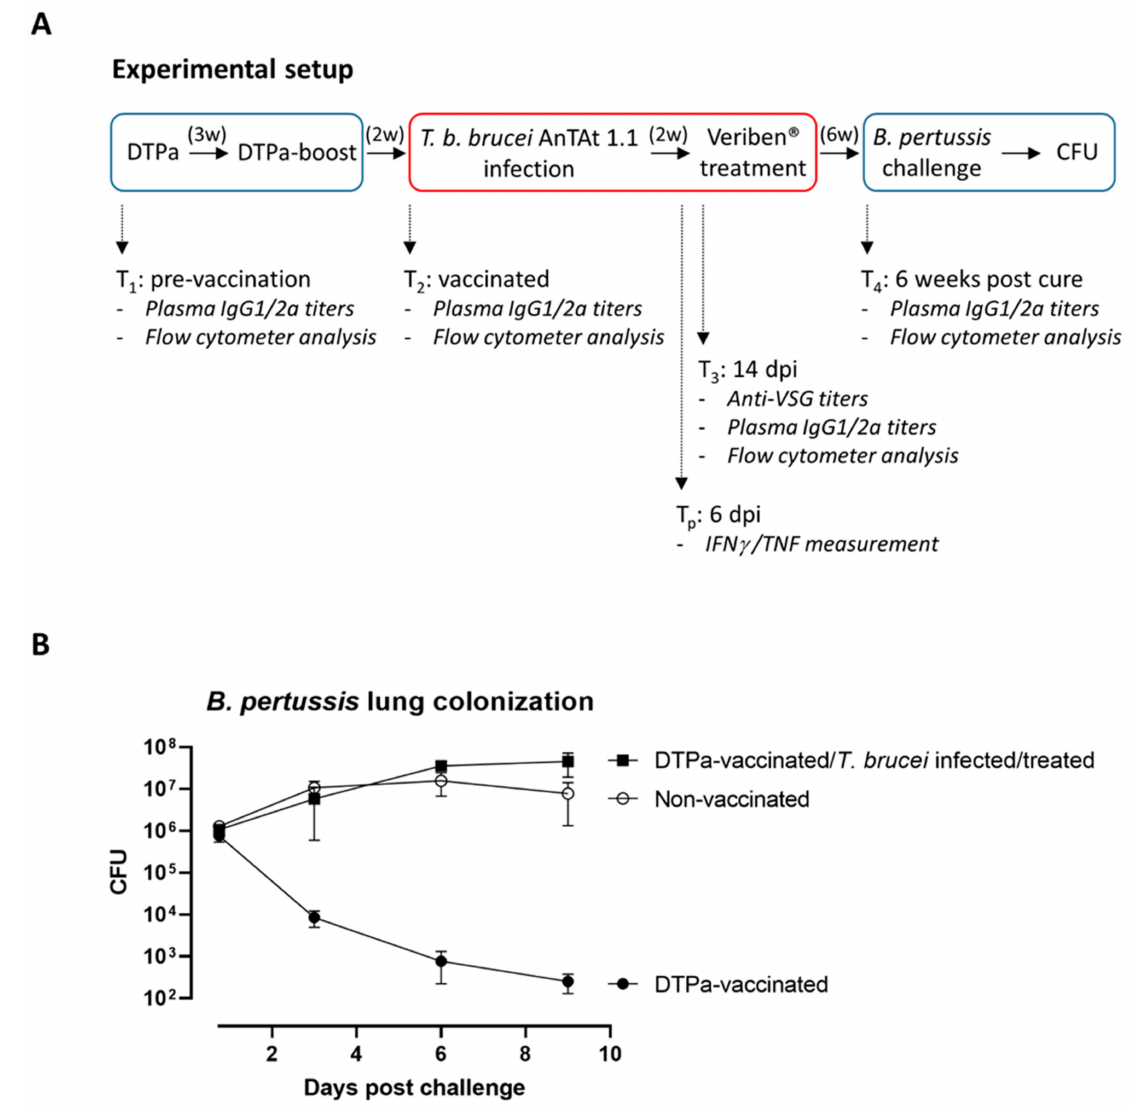
Figure 1. ( A ) Experimental layout. Mice were vaccinated and boosted with DTPa with a three-week interval, followed by intraperitoneal challenge with 5000 T. b. brucei AnTat 1.1 parasites. Two weeks into the infection all mice were treated with diminazene diaceturate (40 mg/kg). After a 6-week recovery period, mice were exposed to an intranasal challenge with 5 × 10 6 B. pertussis bacteria (ATCC 9797 reference strain) in 10 µ L DPBS. Subsequently, lung bacterial load clearance was monitored by CFU determination. Anti-pertussis plasma antibody titer determination (IgG1 and IgG2a) as well as flow cytometry analysis of the spleen was executed at T 1 , T 2, T 3 and T 4 . Plasma ELISAs for IFN γ and TNF were performed at the peak of the T. b. brucei infection T p (peak timepoint = 6 dpi). Control groups included naïve mice, non-vaccinated T. b. brucei -infected mice and DTPa-vaccinated mice that were not challenged with trypanosomes. ( B ) Experimental infection with T. b. brucei leads to the permanent abrogation of DTPa vaccine protection against B. pertussis . Bordet-Gengou agar plate lung homogenate CFUs were determined after 18 h as well as after 3, 6 and 9 days of infection. CFUs were measured after 72 h incubation and are represented as the mean ± SD of three individual mice per